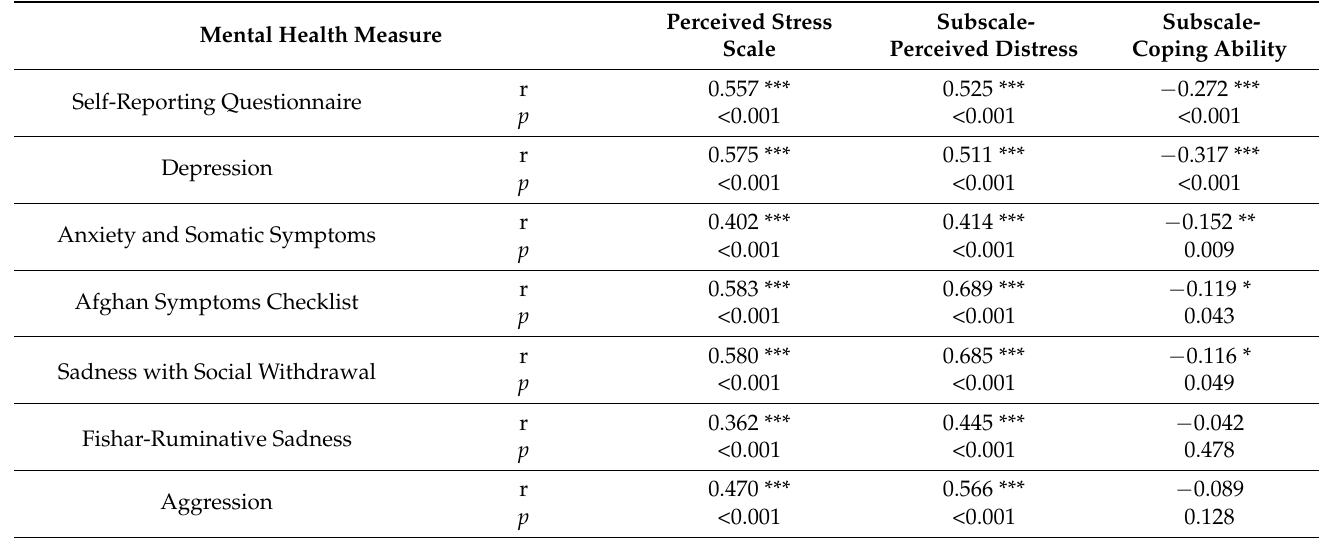
Table 3. Correlation analyses for mental health scores and perceived stress and coping